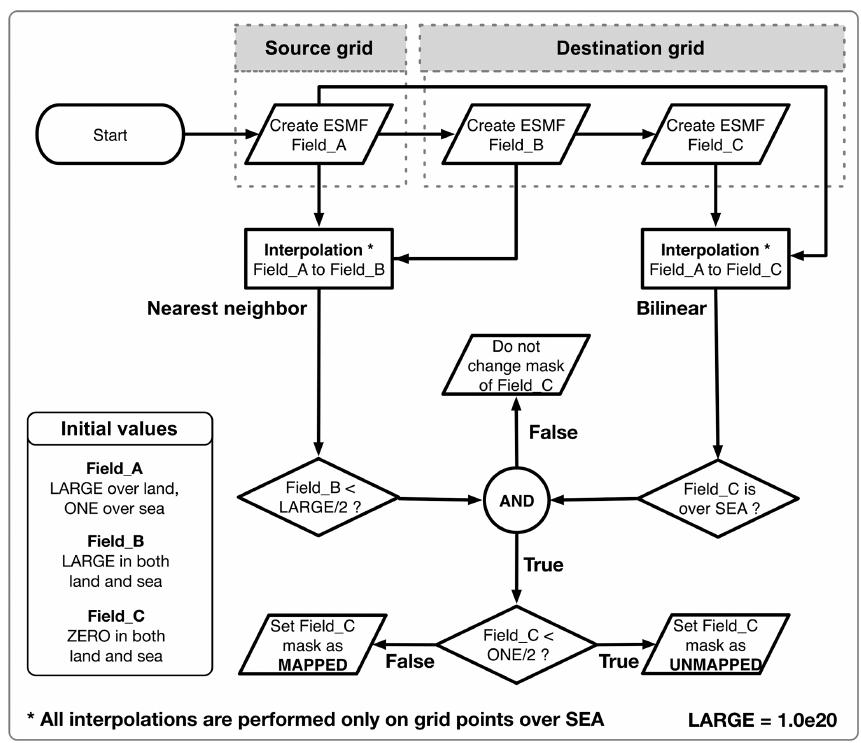
Figure 4. Processing flowchart of the algorithm to find mapped and unmapped grid points for two-step